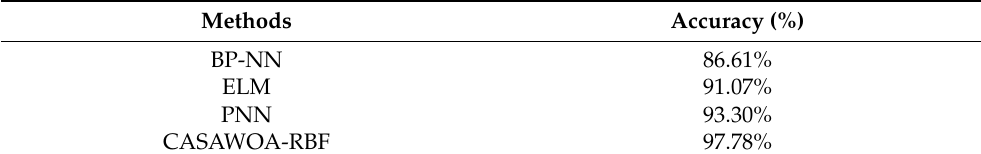
Figure 7. The results of fault diagnosis of the three WOA based RBF networks: ( a ) GWO-RBF;